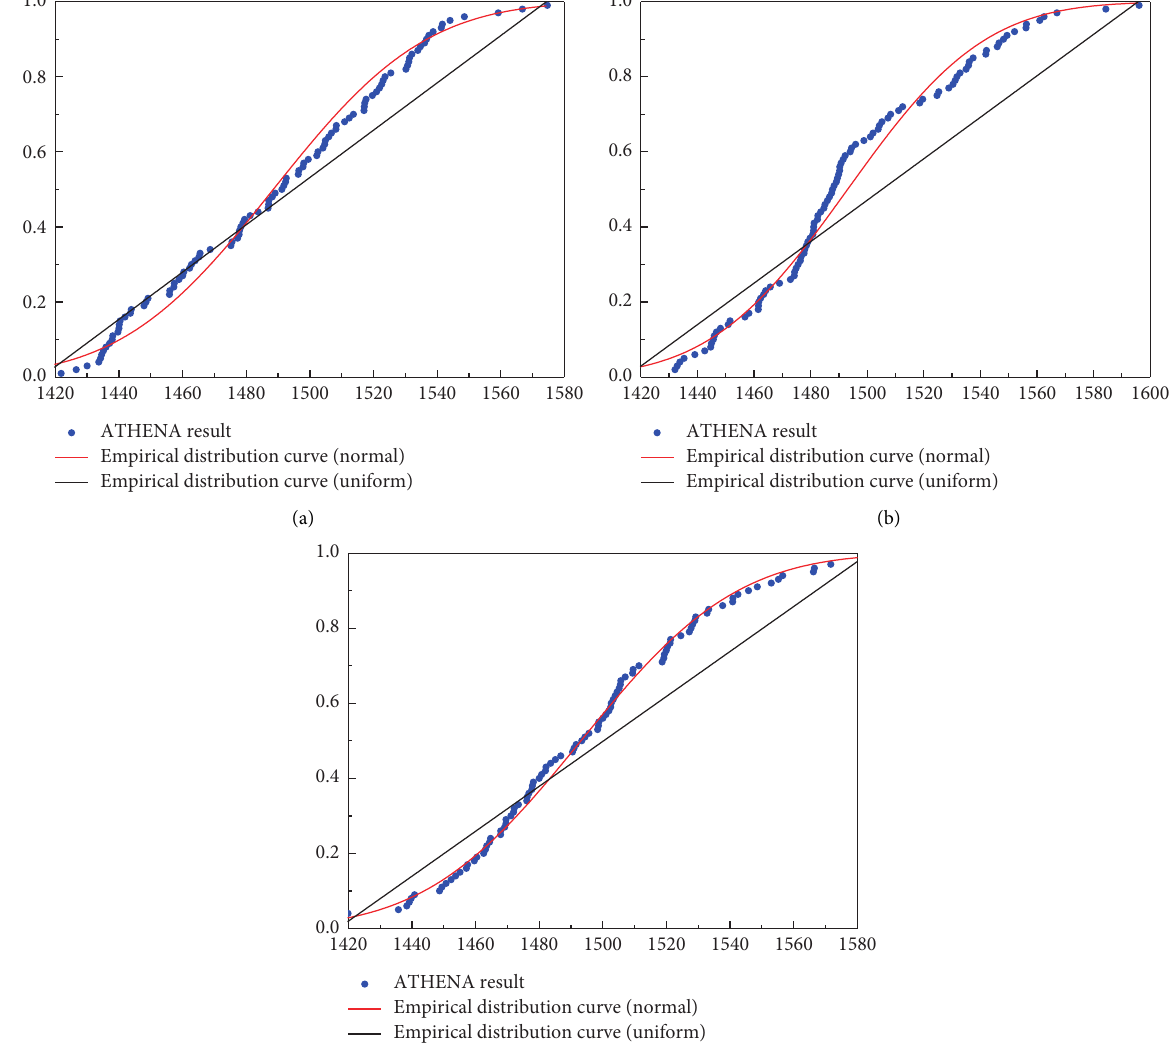
Figure 10: CDFs and fitted normal distribution results with inputs of normal distribution. (a) SRS. (b) LHS. (c)